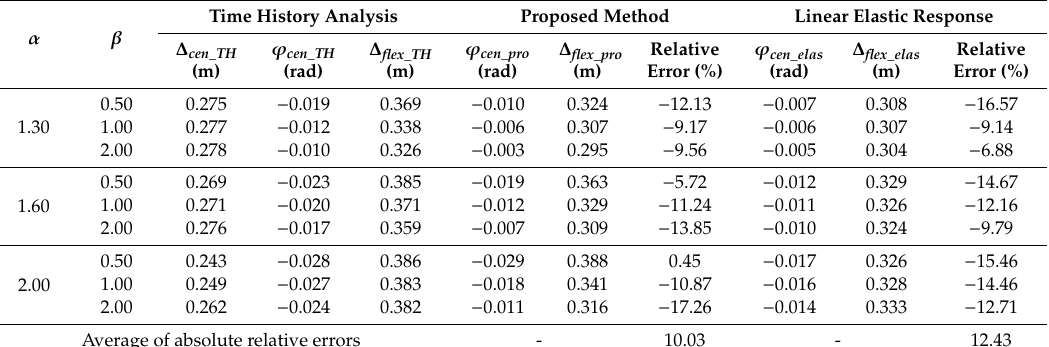
Table 4. Results of the time history analysis, the proposed method and the linear elastic response. (El Centro).